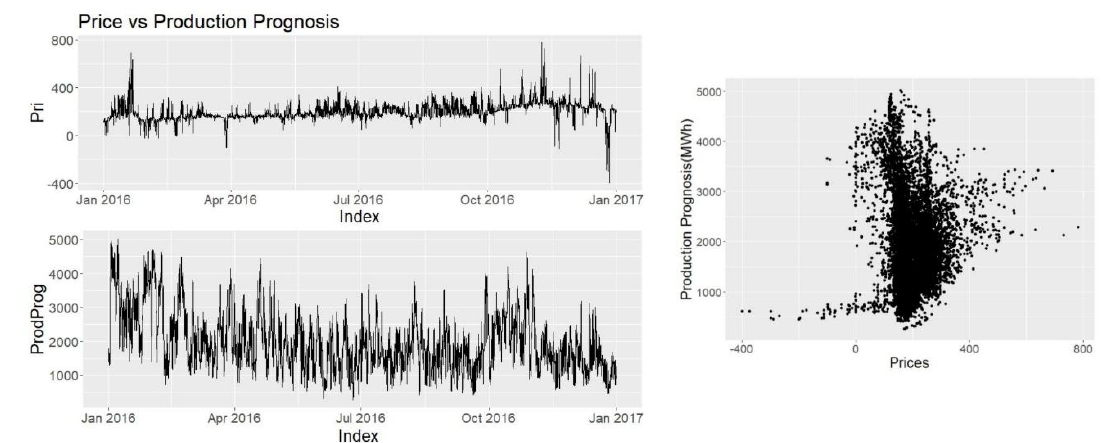
Figure 10. Price vs. Production prognosis.